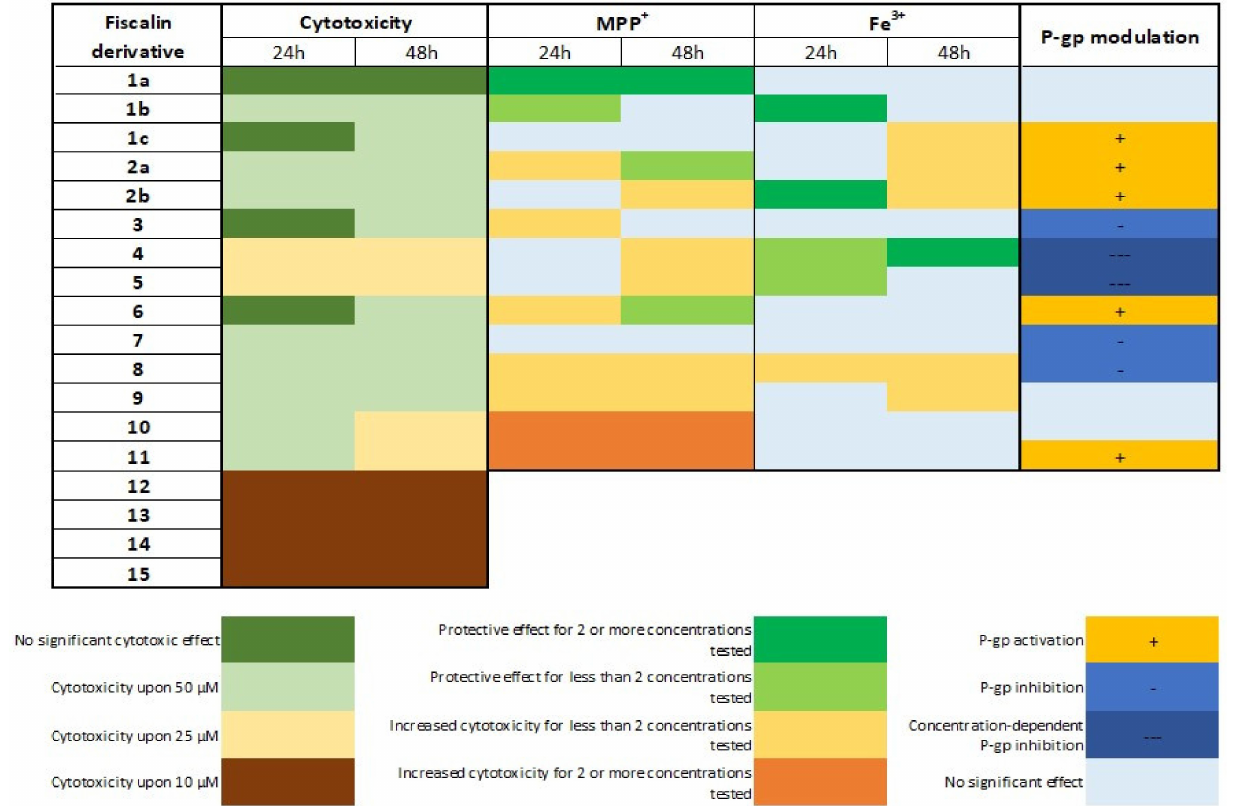
Figure 7. Overview of the results obtained for all the fiscalin derivatives ( 1a , 1b , 1c , 2a , 2b , 3 – 15 ) under investigation in the present